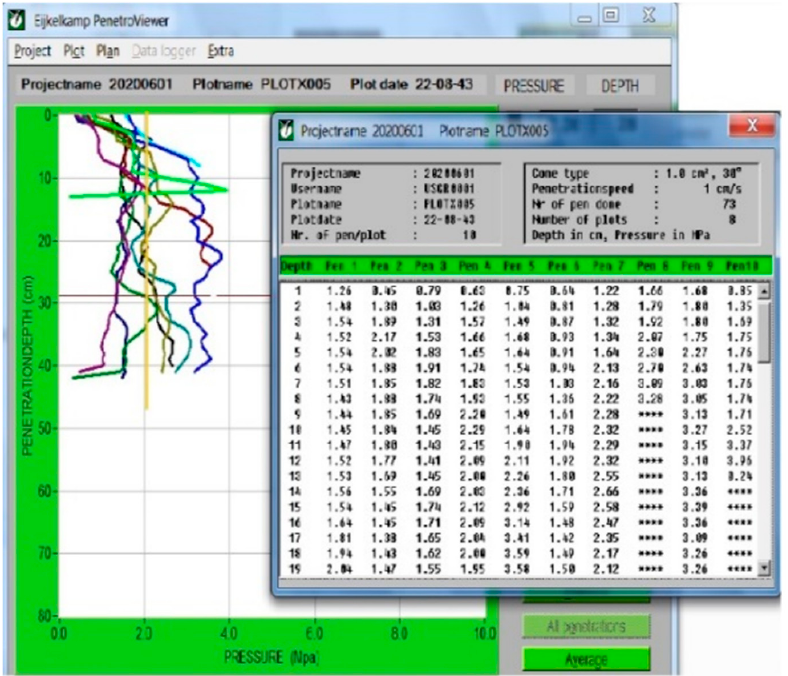
Figure 2. An example of soil cone penetrometer data at different depths along with the baseline (2.07 MPa).